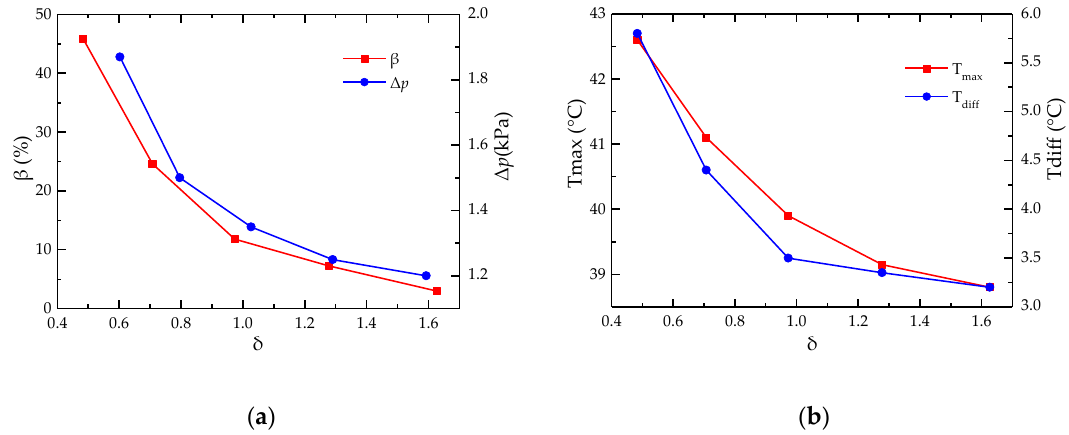
Figure 10. The effect of δ on several parameters, at Q = 5 L/min, N = 0: ( a ) β and Δ p ; ( b ) T max and T diff .